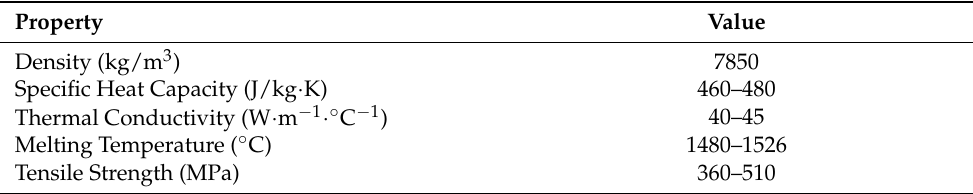
Table 2. Physical and mechanical properties of the S235 for laser